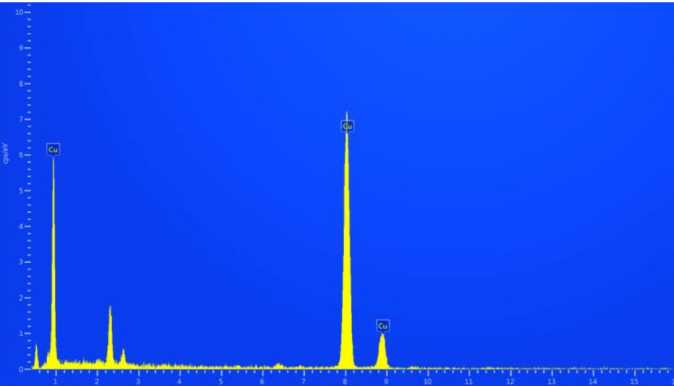
Figure 3. Energy dispersive X-ray spectroscopy (EDS) spectrum with peaks corresponding to copper.